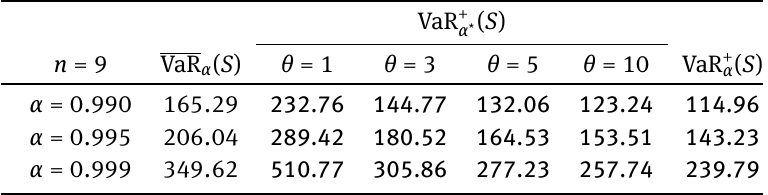
Table 3 The same as Table 1 for a inhomogeneous risk vector of n = 9 risks with F 1 = F 2 = F 3 = Pareto(2), F 4 = F 5 = F 6 = LogN(0.2, 1) and F 7 = F 8 = F 9 = Gamma(3, 2), and Gumbel copula lower bound C X ≥ C Gu Estimates of VaR α ( S ) have been computed via the Rearrangement Algorithm; see